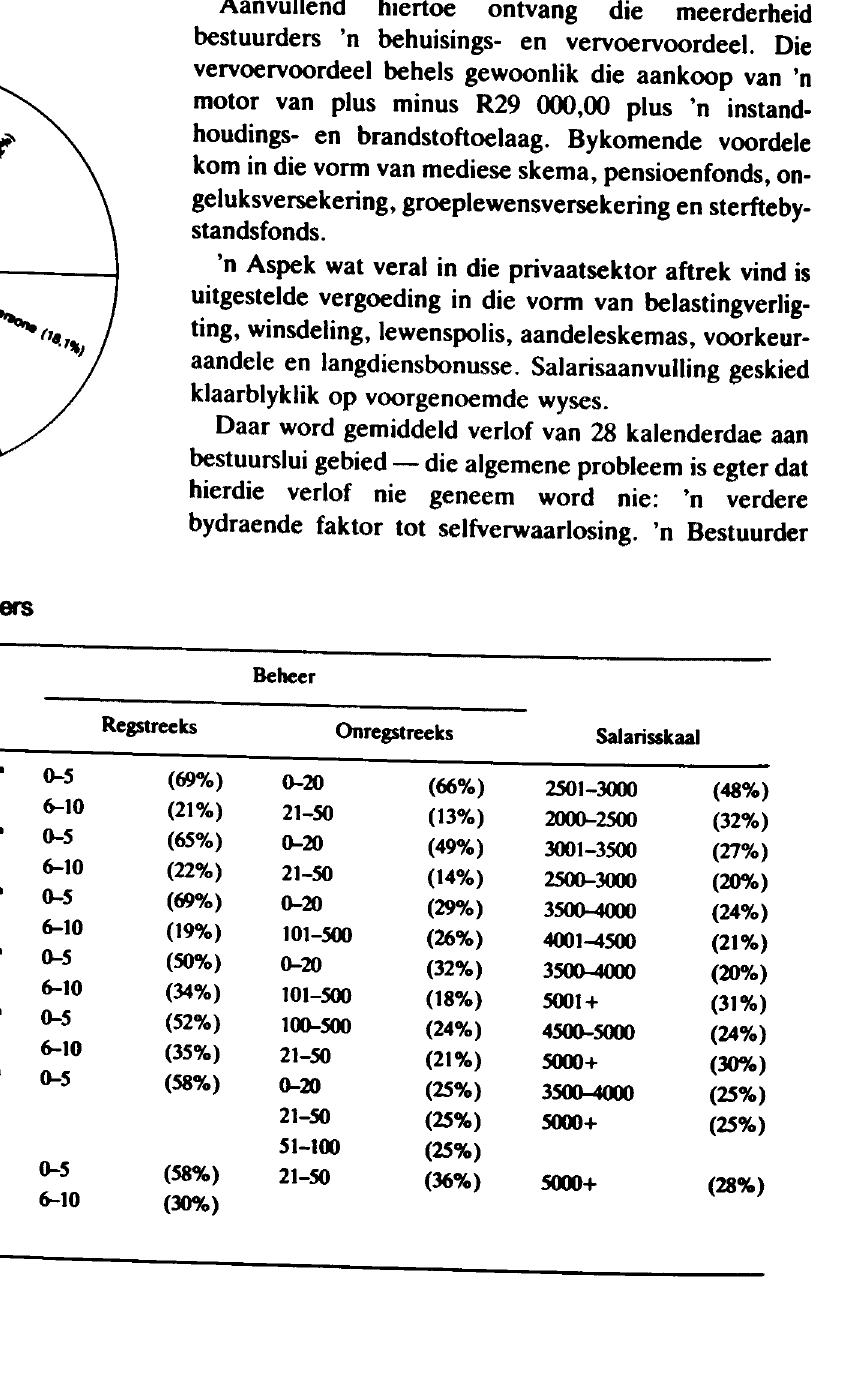
Figu..- 2 Spanwydte van beheer